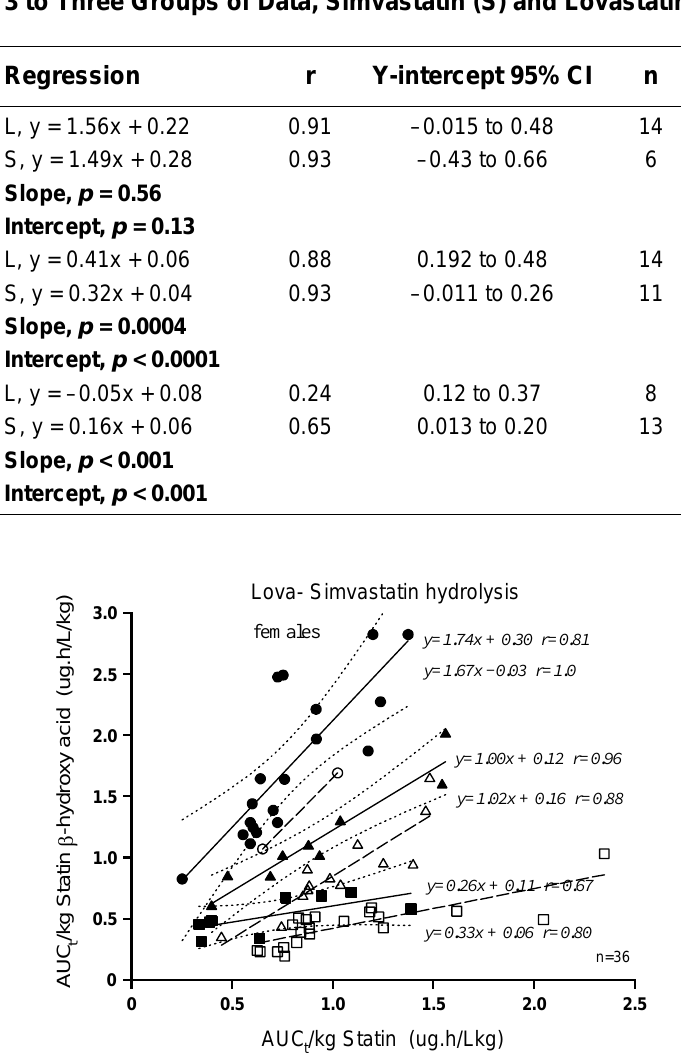
Reduction of the Whole Data Fan (n = 2 × 34) in Males in Fig. 3 to Three Groups of Data, Simvastatin (S) and Lovastatin (L)